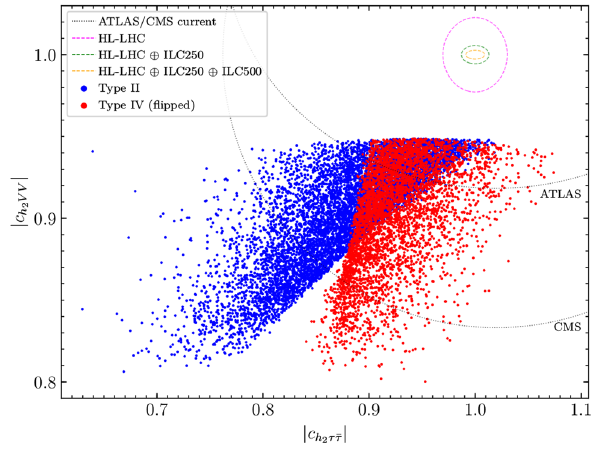
| on the vertical 2 VV